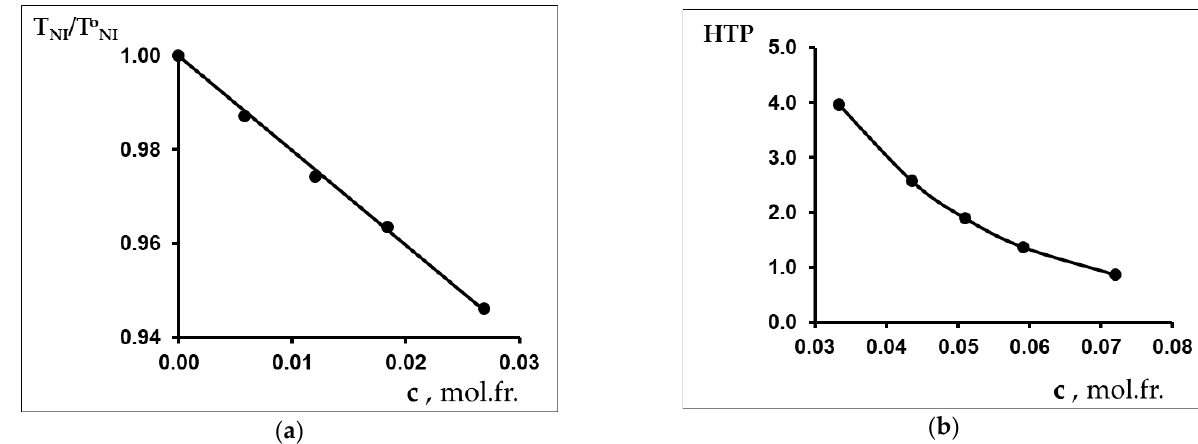
( c ) Figure 4. Marble texture of CB-2 at 70.1 °C ( a ). Fingerprint texture of CB-2 + 8.7% CPDA mixture at 45 °C ( b ) and Newton ’ s rings system of CB-2 + 5.263% CPDA mixture at 35.8 °C ( c ).